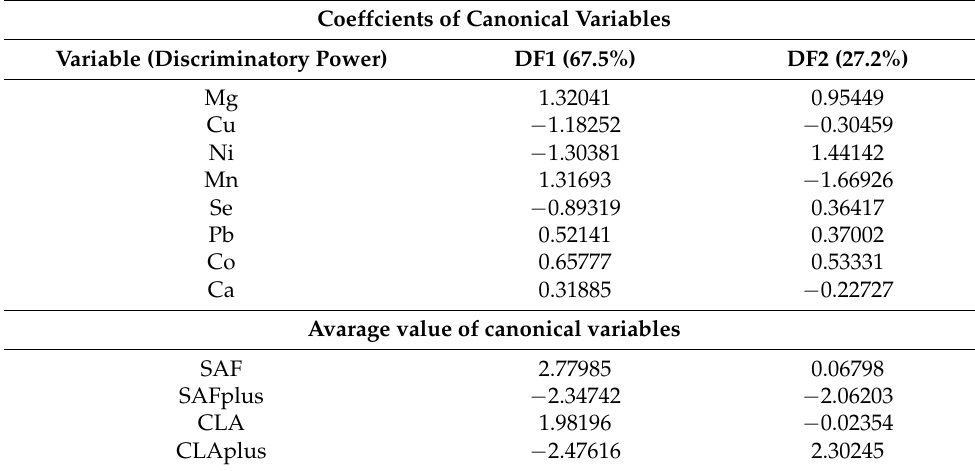
Table 5. Coefficients and average value of canonical variables included in the final model.